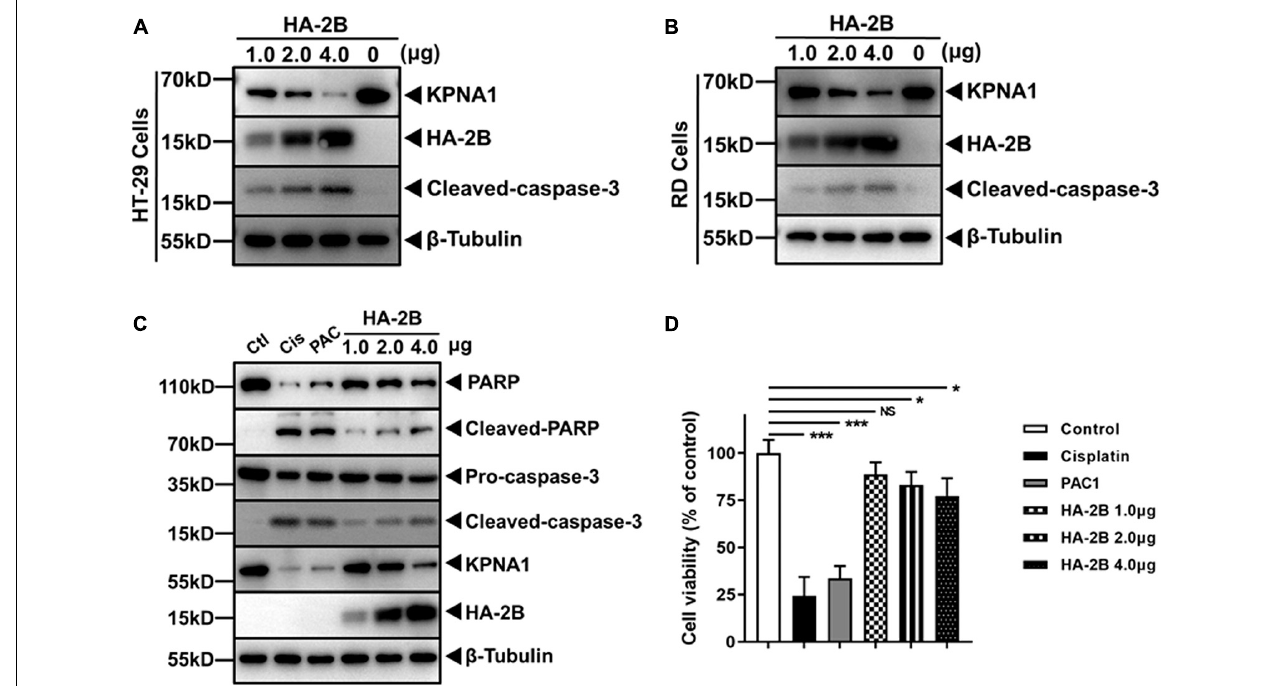
FIGURE 5 | Viral 2B induced KPNA1 degradation in various cell types and intrinsic apoptosis. (A,B) Degradation of KPNA1 and cleaved-caspase-3 were detected in HT-29 (A) and RD (B) cells. Cells transfected with plasmids expressing HA-tagged 2B and cell lysates were prepared 36 h post transfection with varying amounts of plasmids for western blot analyses with antibodies for KPNA1, HA, cleaved-caspase-3, or β -Tubulin. (C) 2B induced PARP cleavage as well as KPNA1 degradation. HeLa cells were treated with Cisplatin (30 µ M) or PAC1 (50 µ M), or transfected with different amounts of plasmids expressing HA-tagged 2B for 36 h. Whole cell lysates were collected for western blot analyses with specific antibodies. Ctl, untreated group; Cis, Cisplatin; PAC, PAC1. (D) Cell viabilities with 2B expression. HeLa cells were treated with Cisplatin or PAC1, or transfected with plasmids expressing HA-tagged 2B. The cells were assessed with the CCK-8 assay for cell viability. The values represented mean ± SD from triplicates of independent experiments and the viability of negative control cells without any treatment was set as